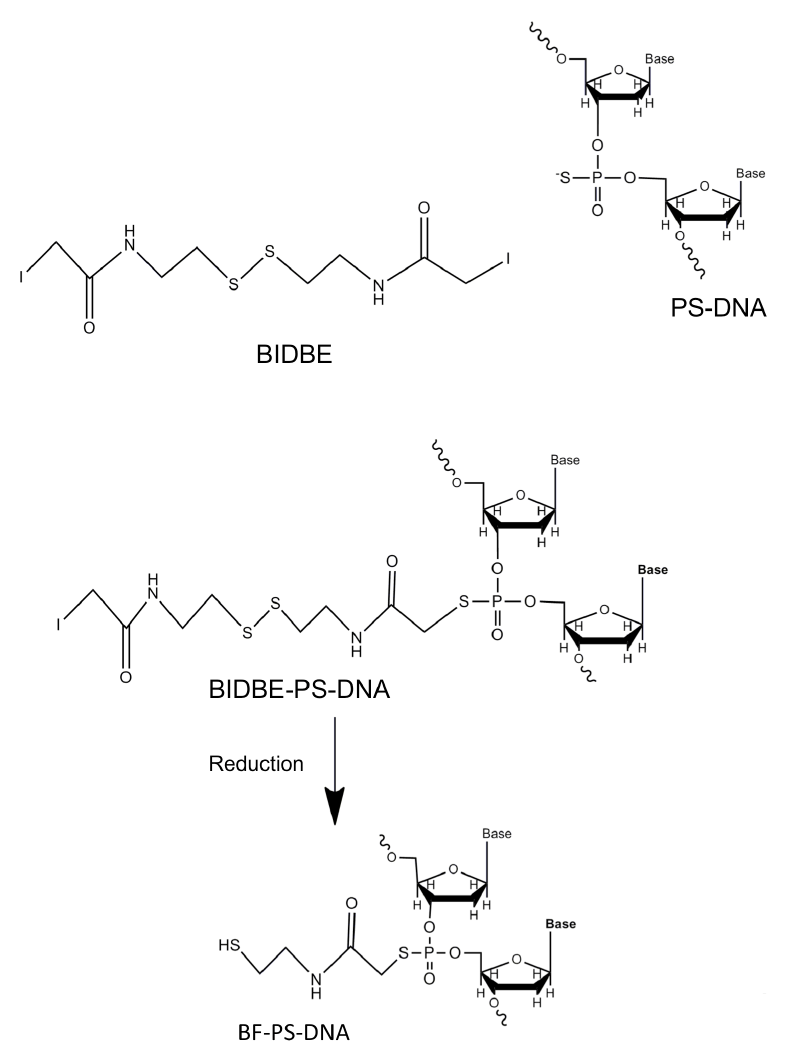
Figure 1. BIDBE binds to Phosphorothioate DNA (PS-DNA) to form BIDBE-PS-DNA, which can then be reduced to form bifunctional linker (BF) attached to PS-DNA. BF provides a sulfhydryl group for attachment to GNPs. Reprinted (adapted) from Ref. [34], with permission from Wiley. Copyright 2007 WILEY-VCH Verlag GmbH & Co. KGaA, Weinheim.